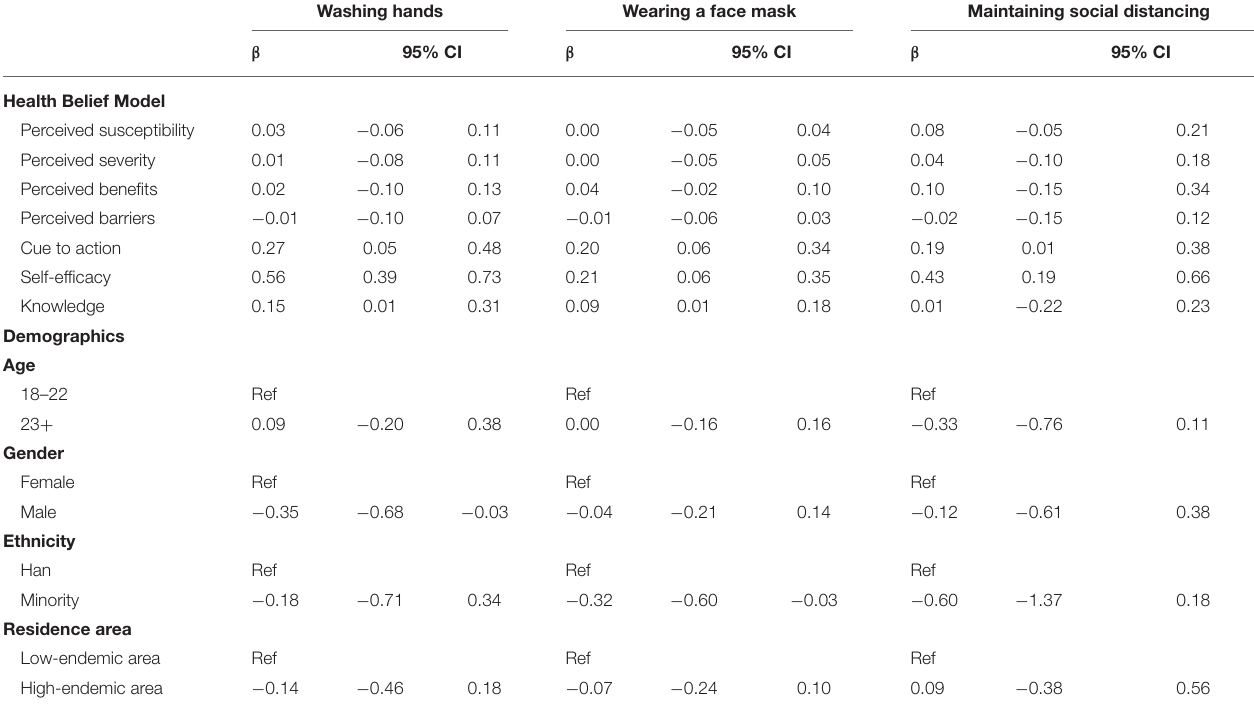
TABLE 3 | Multivariate linear regressions on preventive health behaviors. Washing hands Wearing a face mask Maintaining social